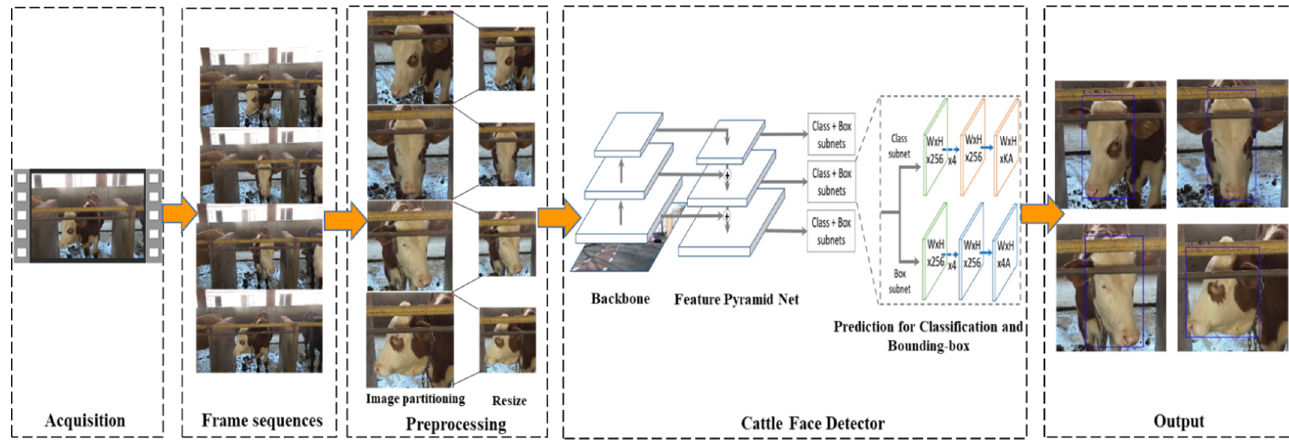
Figure 1. The proposed framework for the detection of multi-view cattle face based on RetinaNet.